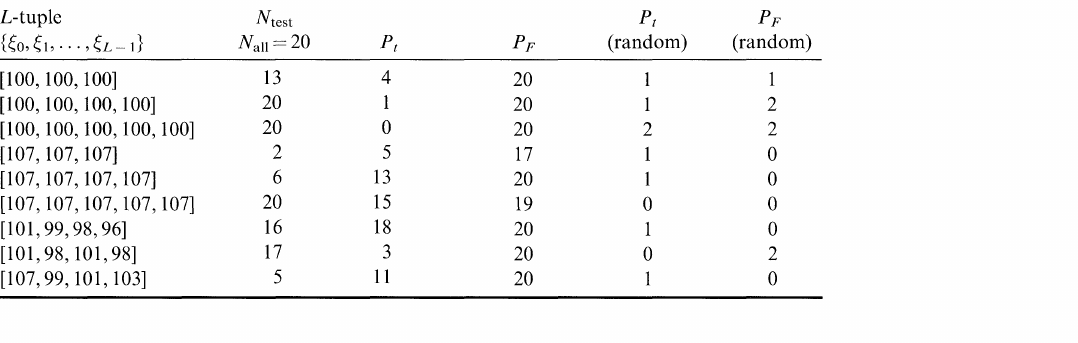
TABLE III Results of the selection procedure for binomial model time series which have been reordered to generate 25 -tuples given in column 1. Ntest, Nail, Nmatch, and Rsn as in Table